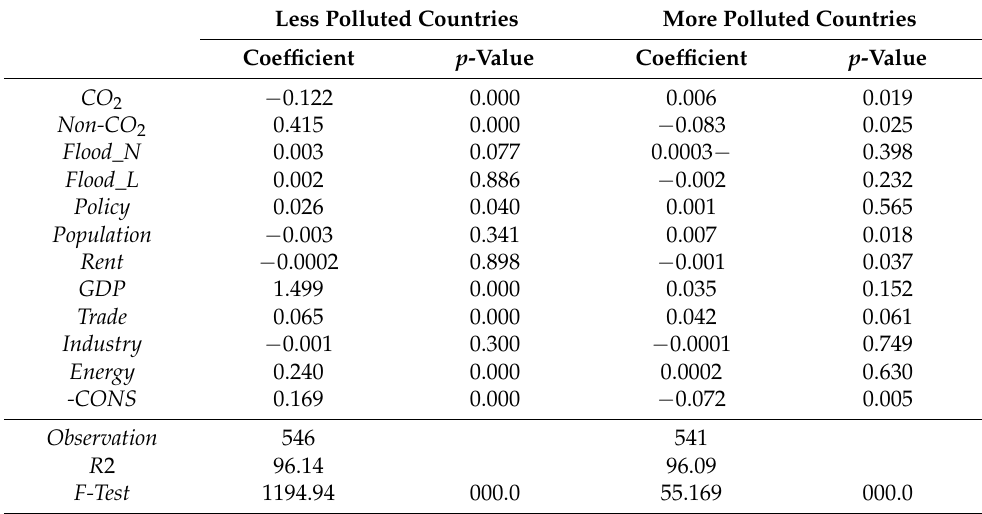
Table 9. Estimation results for the geothermal energy sector in more and less polluted countries. Less Polluted